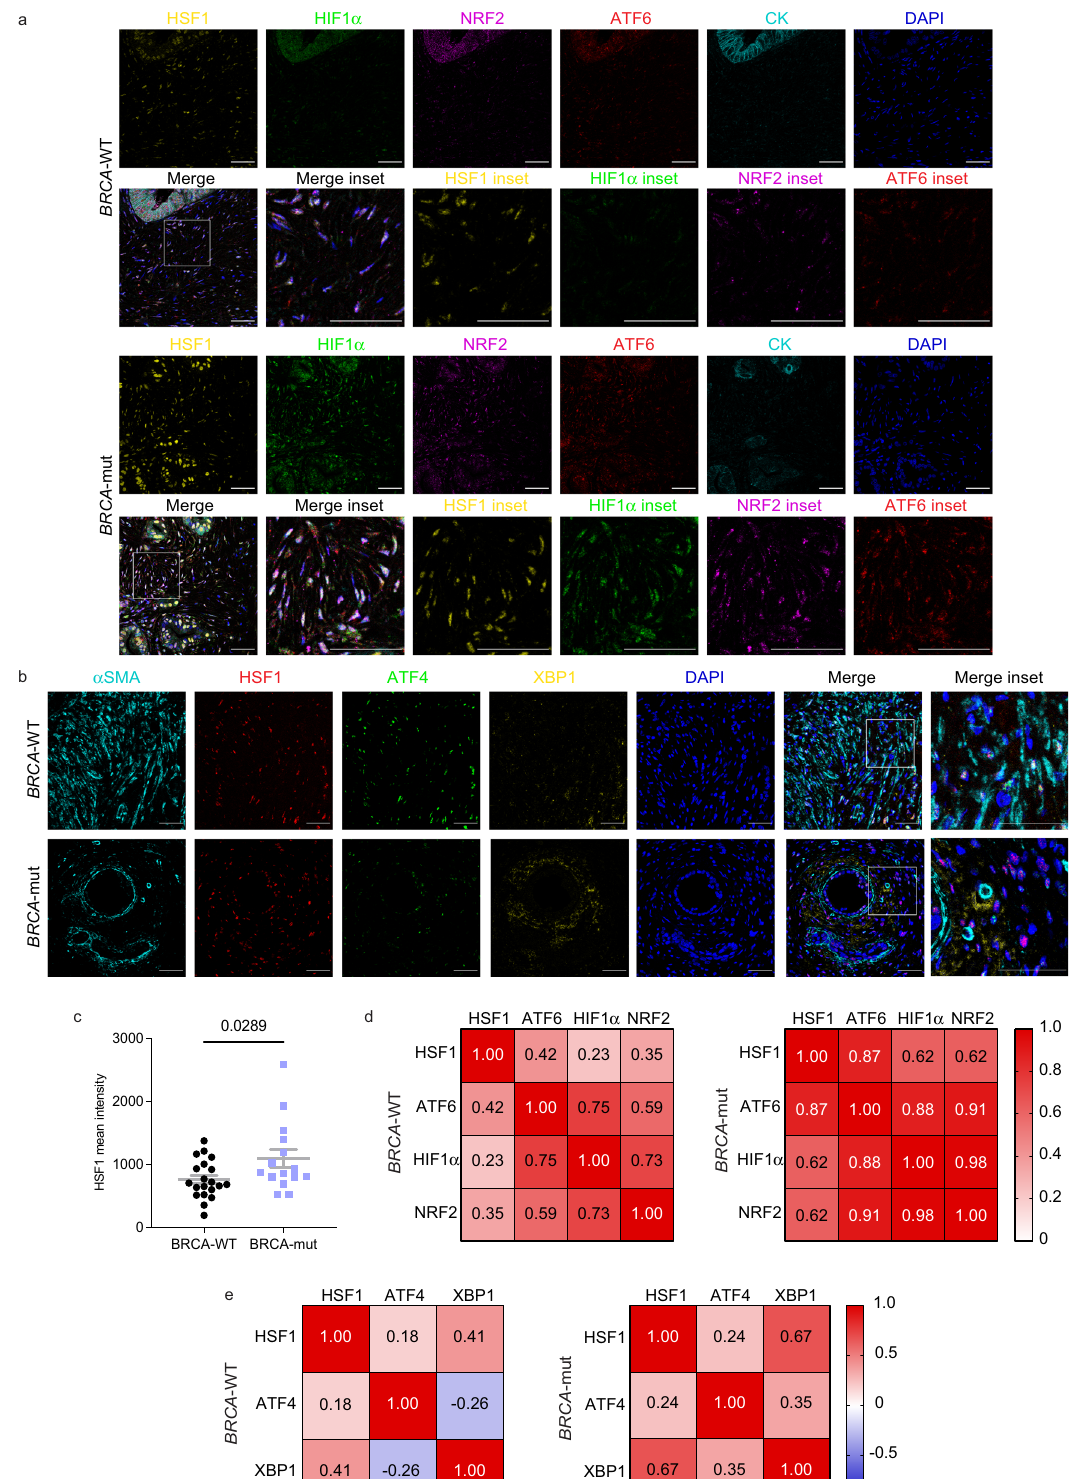
Fig. 3 | A network of stress responses is activated in BRCA -mut stroma. FFPE tumorsections from BRCA -mut and BRCA -WT PDAC patients were stainedby MxIF usingantibodiesfortheindicatedproteins.( a , b )Representativeimagesareshown. DAPI was used to stain nuclei. Scale bar, 50 μ m. ( c ) Quanti fi cation of HSF1 mean intensity within all stromal cells in BRCA -mut (n=14) and BRCA -WT samples ( n =20).3-5imagesperpatientwereanalyzedusingImageJsoftware,HSF1staining